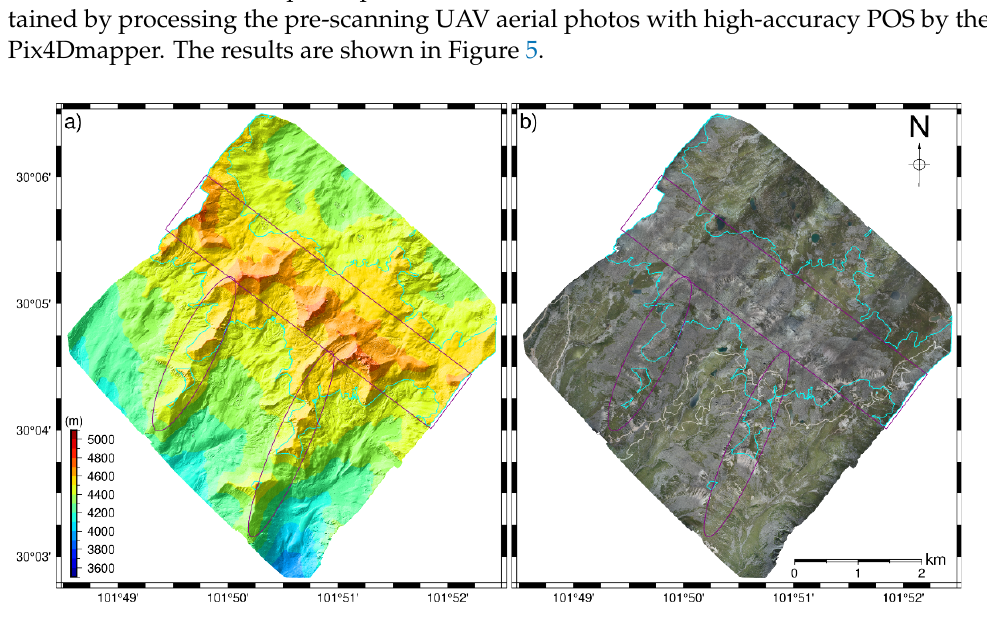
Figure 5. Pre ‐ scan results of the drone: ( a ) surface DSM map; ( b ) orthophoto map. The winding, white line features on the orthophoto map are the roads built for the installation of the transmission line towers. The dark magenta rectangle box is located in the area of the main mountain range, and the two dark magenta ellipses are the areas of the two lower mountains. The polygon area indicated by cyan is the area with an elevation greater than or equal to 4500 m.